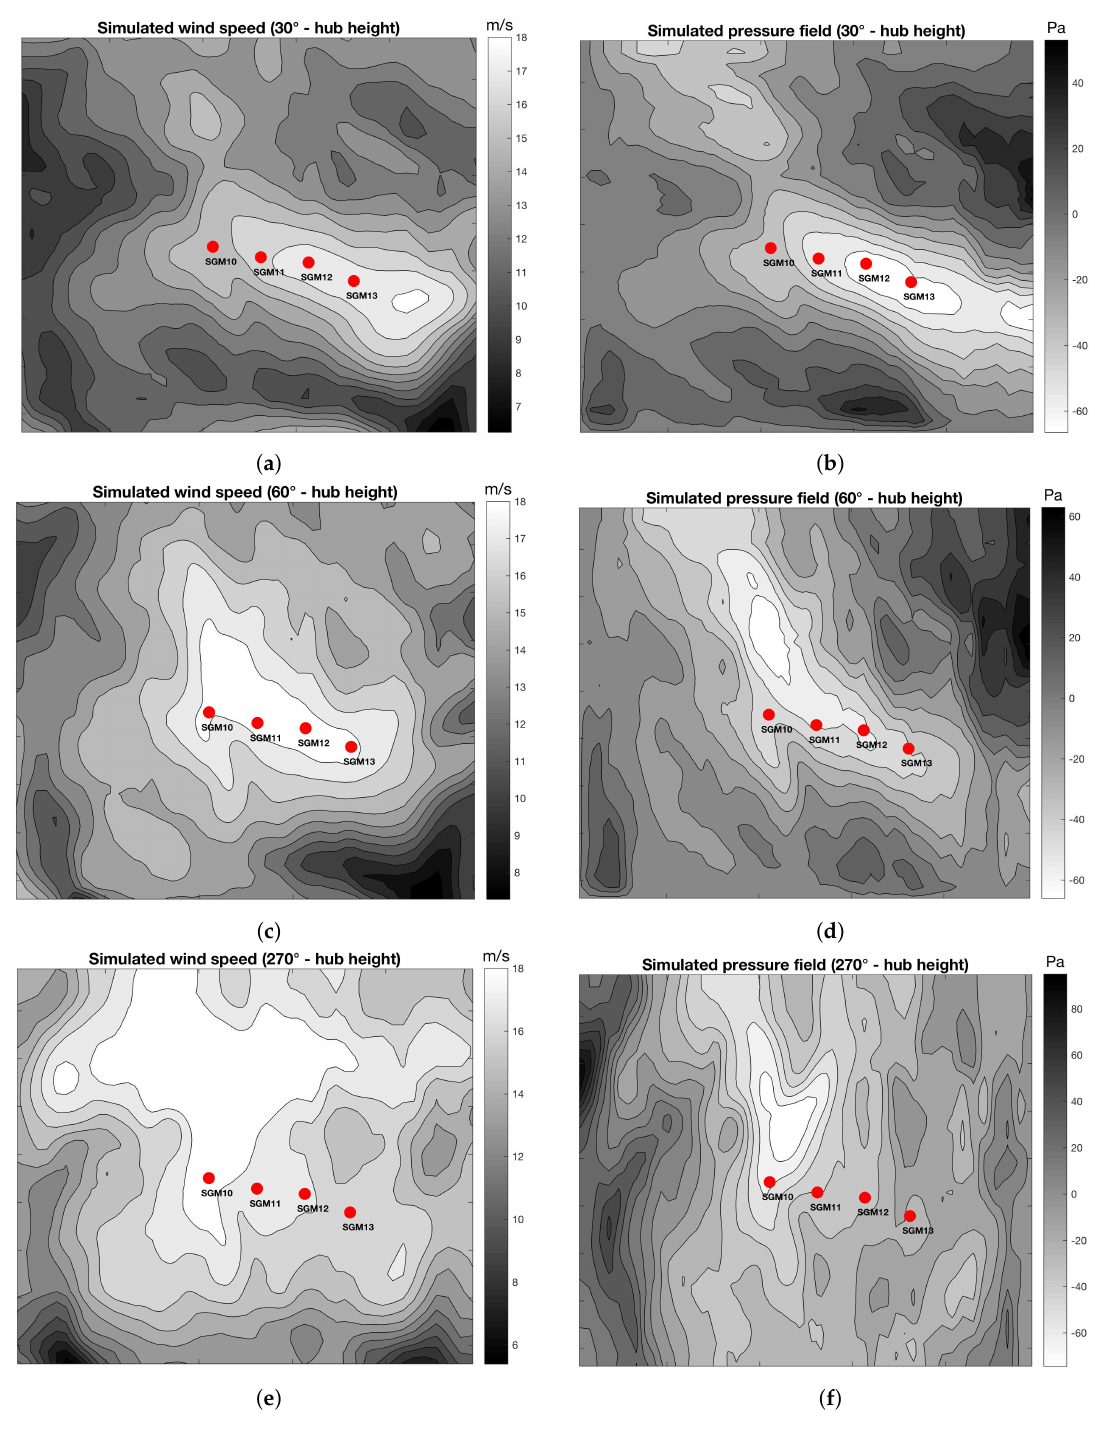
Figure 7. Results from ( a ) the simulated wind field speed at hub height 30 ◦ ; ( b ) the simulated free pressure field at hub height 30 ◦ ; ( c ) the simulated wind field speed at hub height 60 ◦ ; ( d ) the simulated free pressure field at hub height 60 ◦ ; ( e ) the simulated wind field speed at hub height 270 ◦ ; ( f ) the simulated free pressure field at hub height 270 ◦